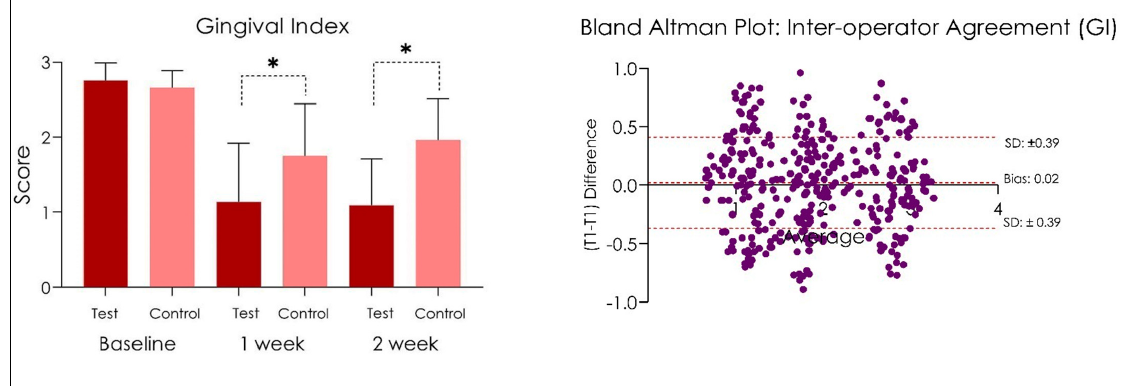
Figure 4. Gingival index score at baseline, after 1 and 2 weeks. * p < 0.05. One-way ANOVA followed by Tukey’s post-hoc test.